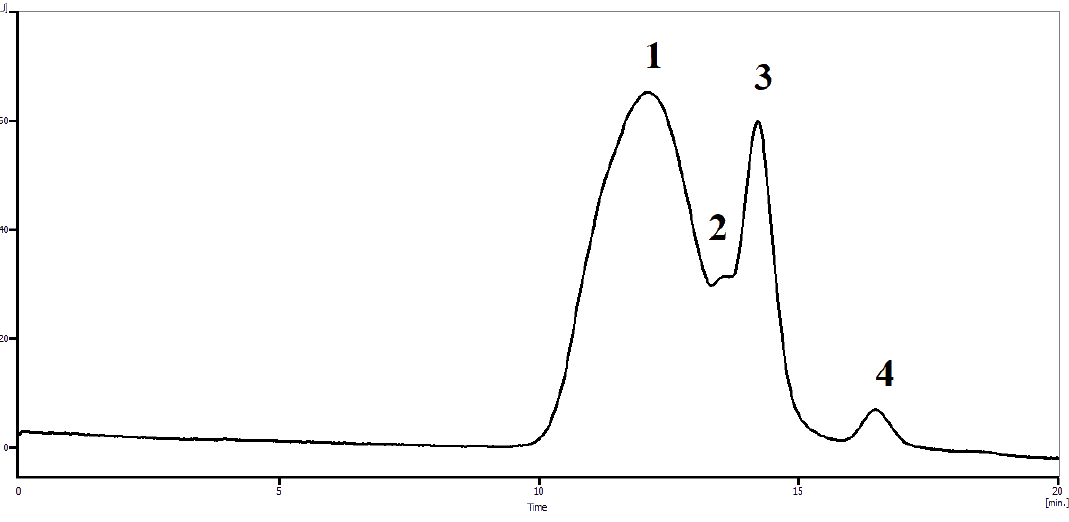
Figure 8. Characteristic chromatographic profile of dynamic equilibrium of [N-VP] n -[N-VA] m [1,4-